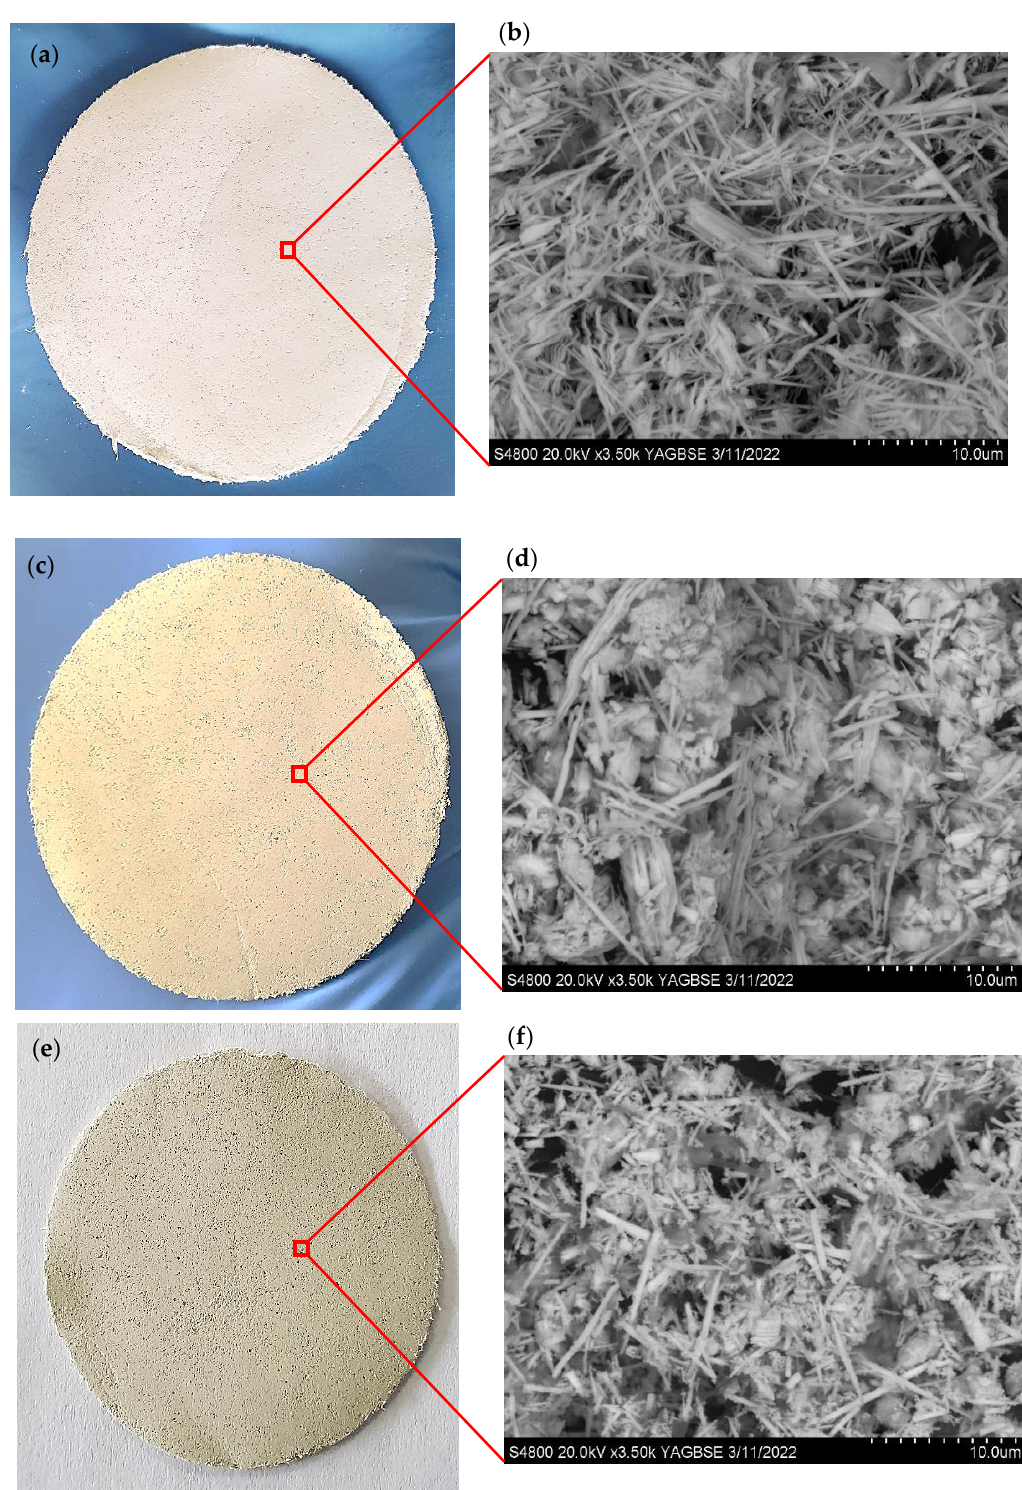
Figure 4. Photographs and SEM images of WO 3 NW/cellulose ( a , b ) WO 3 @Fe 2 O 3 /cellulose ( c , d ) and WO 3 NW@CuO/cellulose ( e , f ) hybrid membranes.